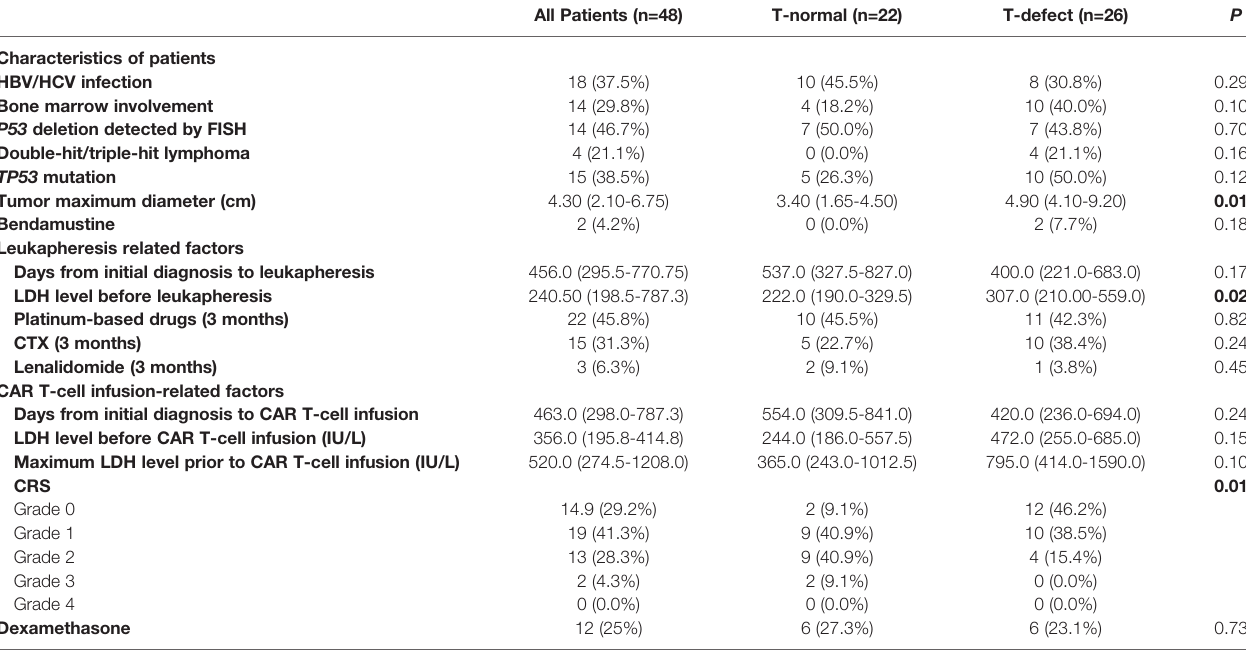
TABLE 2 | Univariate analysis of outcomes in patients treated with CAR-T cells.